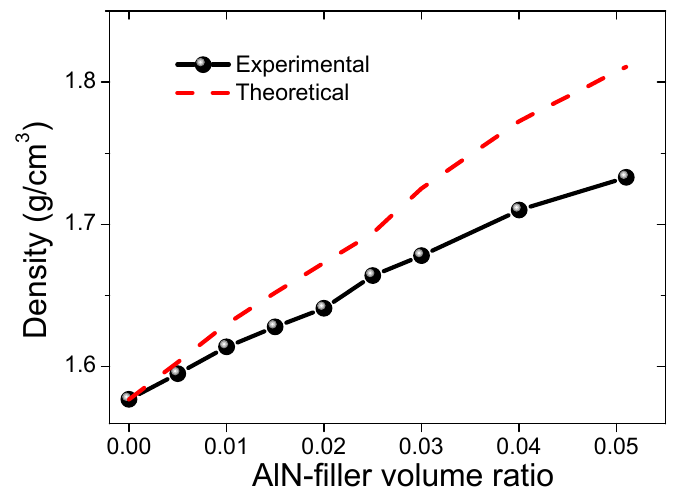
Figure 2. Density of the AlN-filled silicon rubber composite samples.